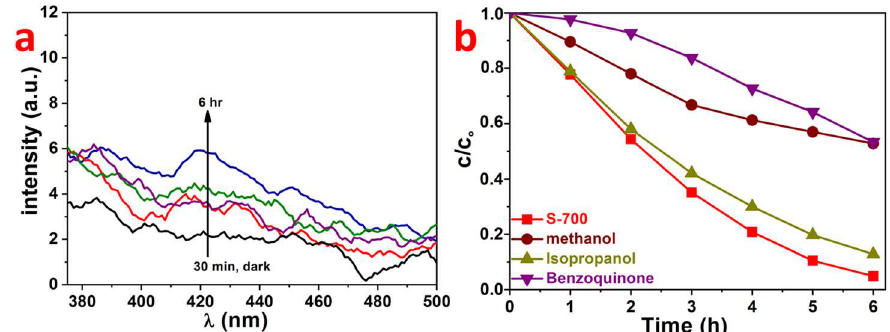
Figure 11. ( a ) Fluorescence spectra of the 2-hydroxyterepthalic acid solution in the presence of LaFeO 3 S-700 and ( b ) the reactive species in trapping experiments during the degradation of RhB.